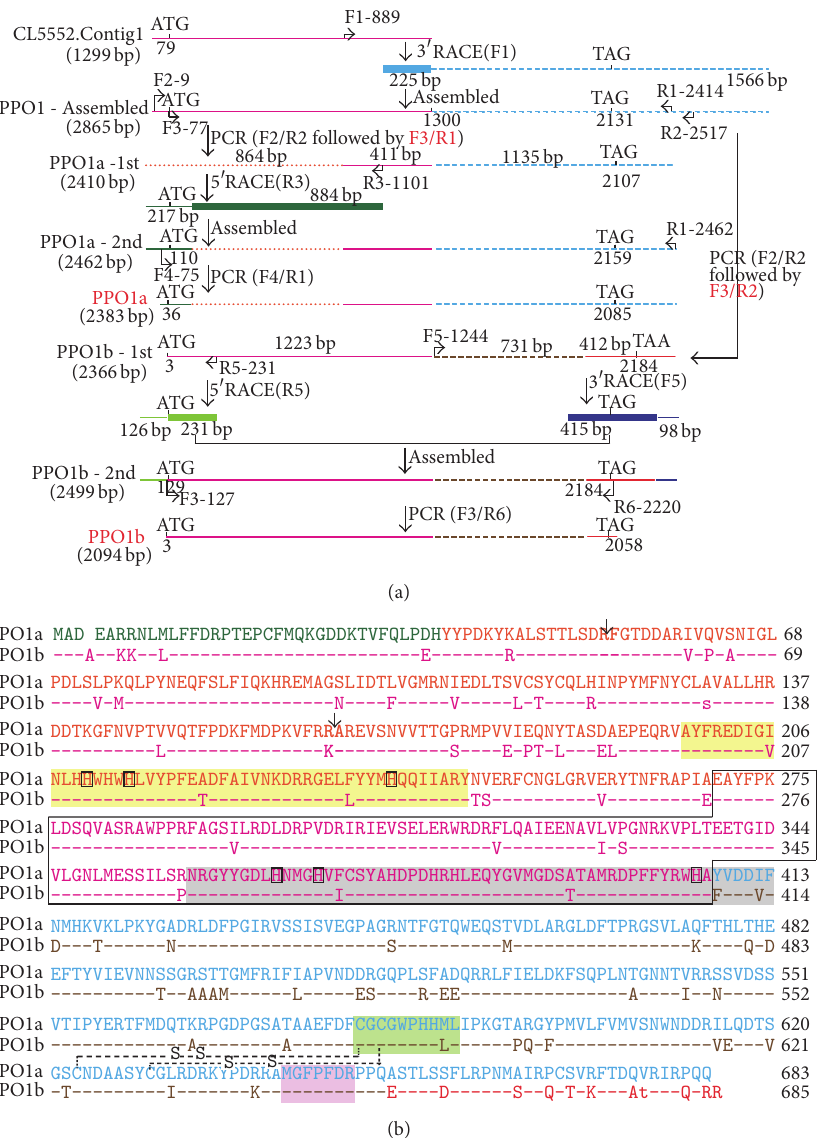
69PPO1a ---A--KK--L------------------------E-------R-------- -- ------V-P-A---- PPO1b PDLSLPKQLPYNEQFSLFIQKHREMAGSLIDTLVGMRNIEDLTSVCSYCQLHINPYMFNYCLAVALLHR 137 ----V-M--------------------N----F-----V-----L-T----R----------s------ 138 DDTKGFNVPTVVQTFPDKFMDPKVFR RA REVSNVVTTGPRMPVVIEQNYTASDAEPEQRVAYFREDIGI 206 ----------L--------------- K- ----------S----E-PT-L---EL--------------V 207 NLHHWHWHLVYPFEADFAIVNKDRRGELFYYMHQQIIARYNVERFCNGLGRVERYTNFRAPIAEAYFPK 275 --------------T-------------L-----------TS----------V---------E------ 276 LDSQVASRAWPPRFAGSILRDLDRPVDRIRIEVSELERWRDRFLQAIEENAVLVPGNRKVPLTEETGID 344 -----------------V------------------------V---------I-S-------------- 345